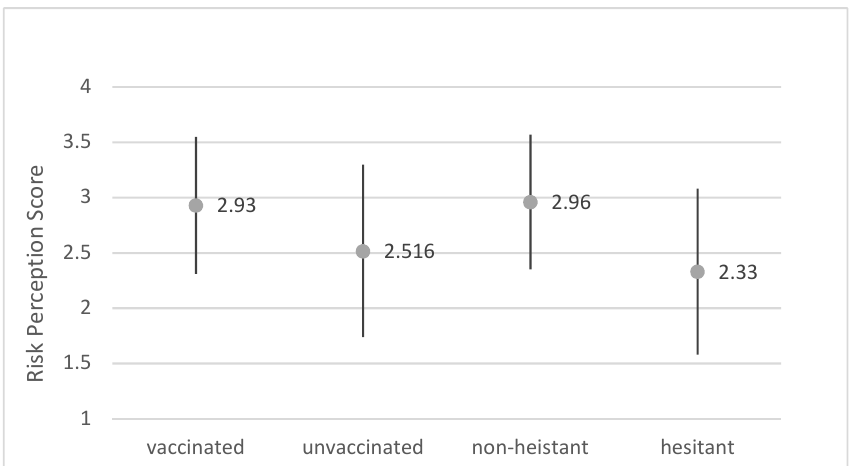
Figure 3. Risk perception toward COVID-19 based on vaccination status and hesitancy. Note: The dots indicate the mean risk perception score on a scale of 1–4 and the vertical lines represent the standard deviation within each subgroup. The risk perceptions between vaccinated and unvaccinated adolescents and between non-hesitant and hesitant adolescents were both significantly different ( p < 0.05).